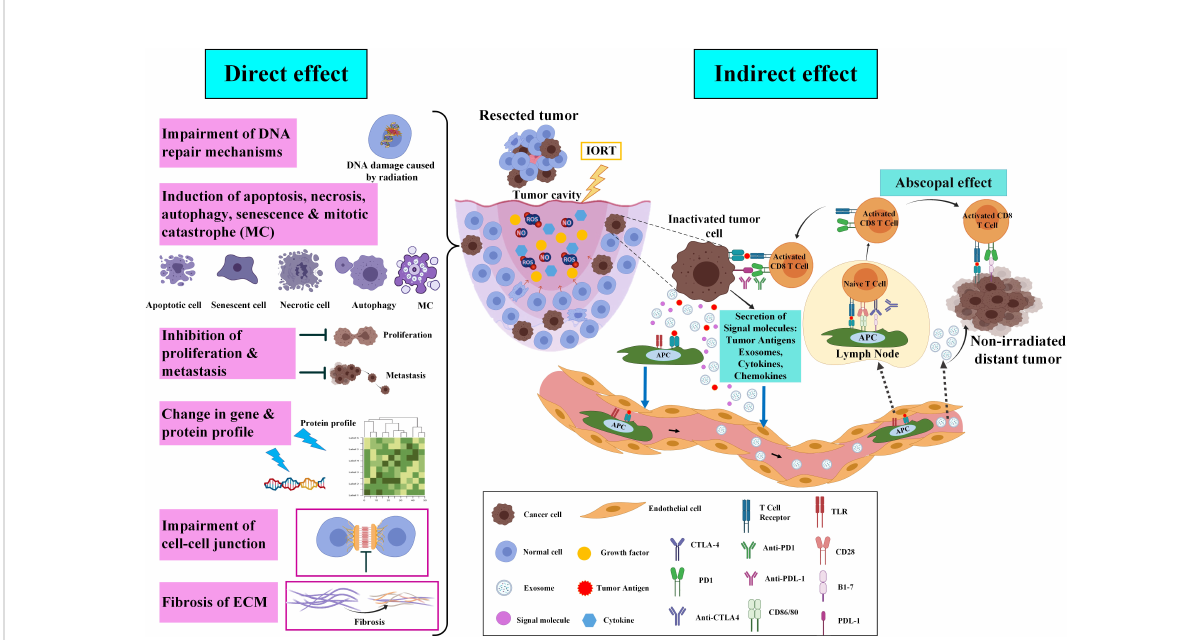
FIGURE 2 Direct and indirect effects of IORT on cancer inhibition and recurrence. After the breast-conserving surgery, molecular and probably remained cancer cells in the tumor cavity will be affected by IORT. Brie fl y, irradiation on the tumor cavity impairs DNA repair mechanisms, induces cell death, inhibits proliferation and metastasis, alters gene and protein pro fi les, impairs the cell-cell junction, and induces ECM fi brosis. In indirect effects of IORT, inactivated remained tumor cells release exosomes and tumor antigens which move and deliver to lymphatic vessels through the circulating system and APCs, respectively. IORT-induced tumor antigens and exosomes effects non-irradiated tumor cells in the body via a mechanism named “ abscopal effect ” (33). The fi gure was created using Biorender